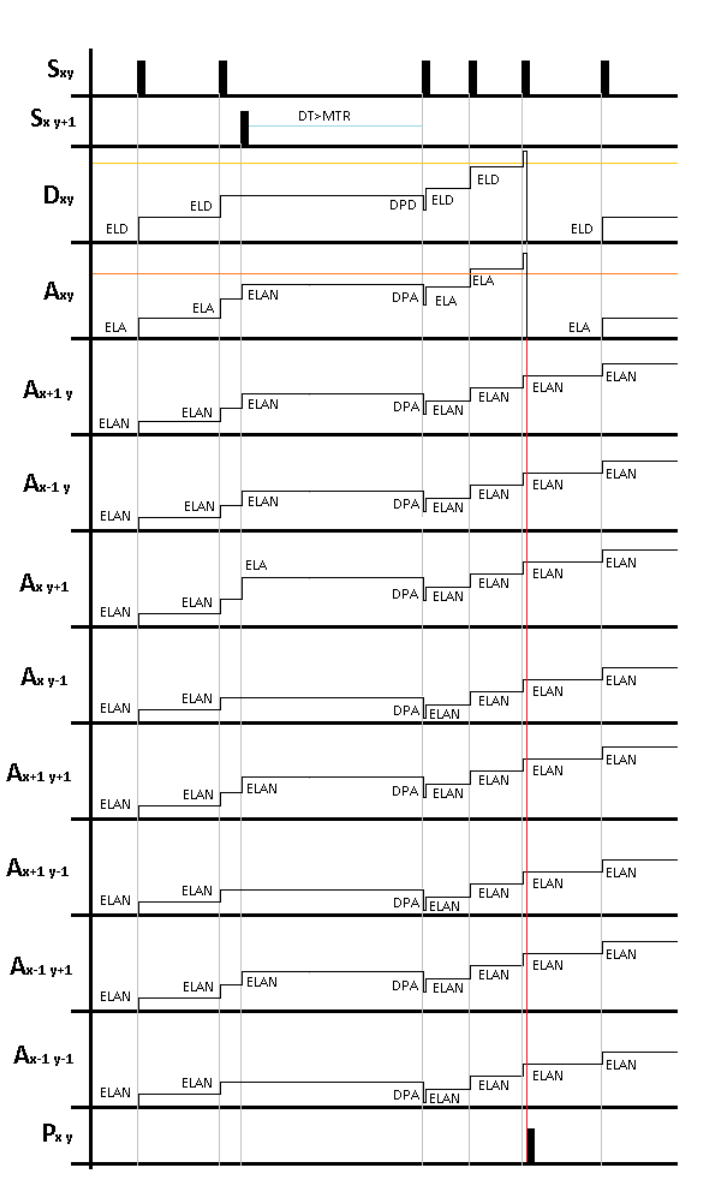
Figure 4. Event processing example in case of input events in two units of Slayer , xy and x ( y + 1 ) . The potential value in each unit increases with input events and, when above a threshold, an output event is generated. If no events exist during a time defined by “MTR”, the potential is decreased. In the case of Dlayer layer, only received events from the same xy unit in the previous layer increase its potential. For Alayer , events received from neighbour units also increase the potential. In each case, a different potential value can be defined. An output event (valued “1”) is generated when the xy units in Dlayer and Alayer are above their respective threshold,